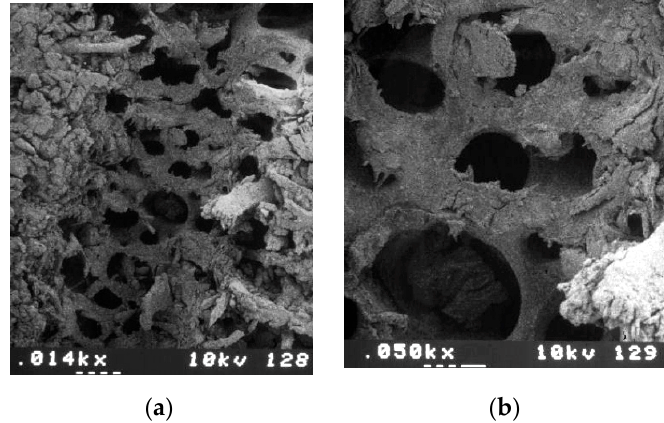
Figure 6. SEM analysis of ultrasonic implant site preparation: ( a ) The spongious structure of the implant site reveals intact trabeculae and a reduction of fractures. ( b ) SEM micrograph magnification shows how the exposed spongious bone presented cleaned surfaces.